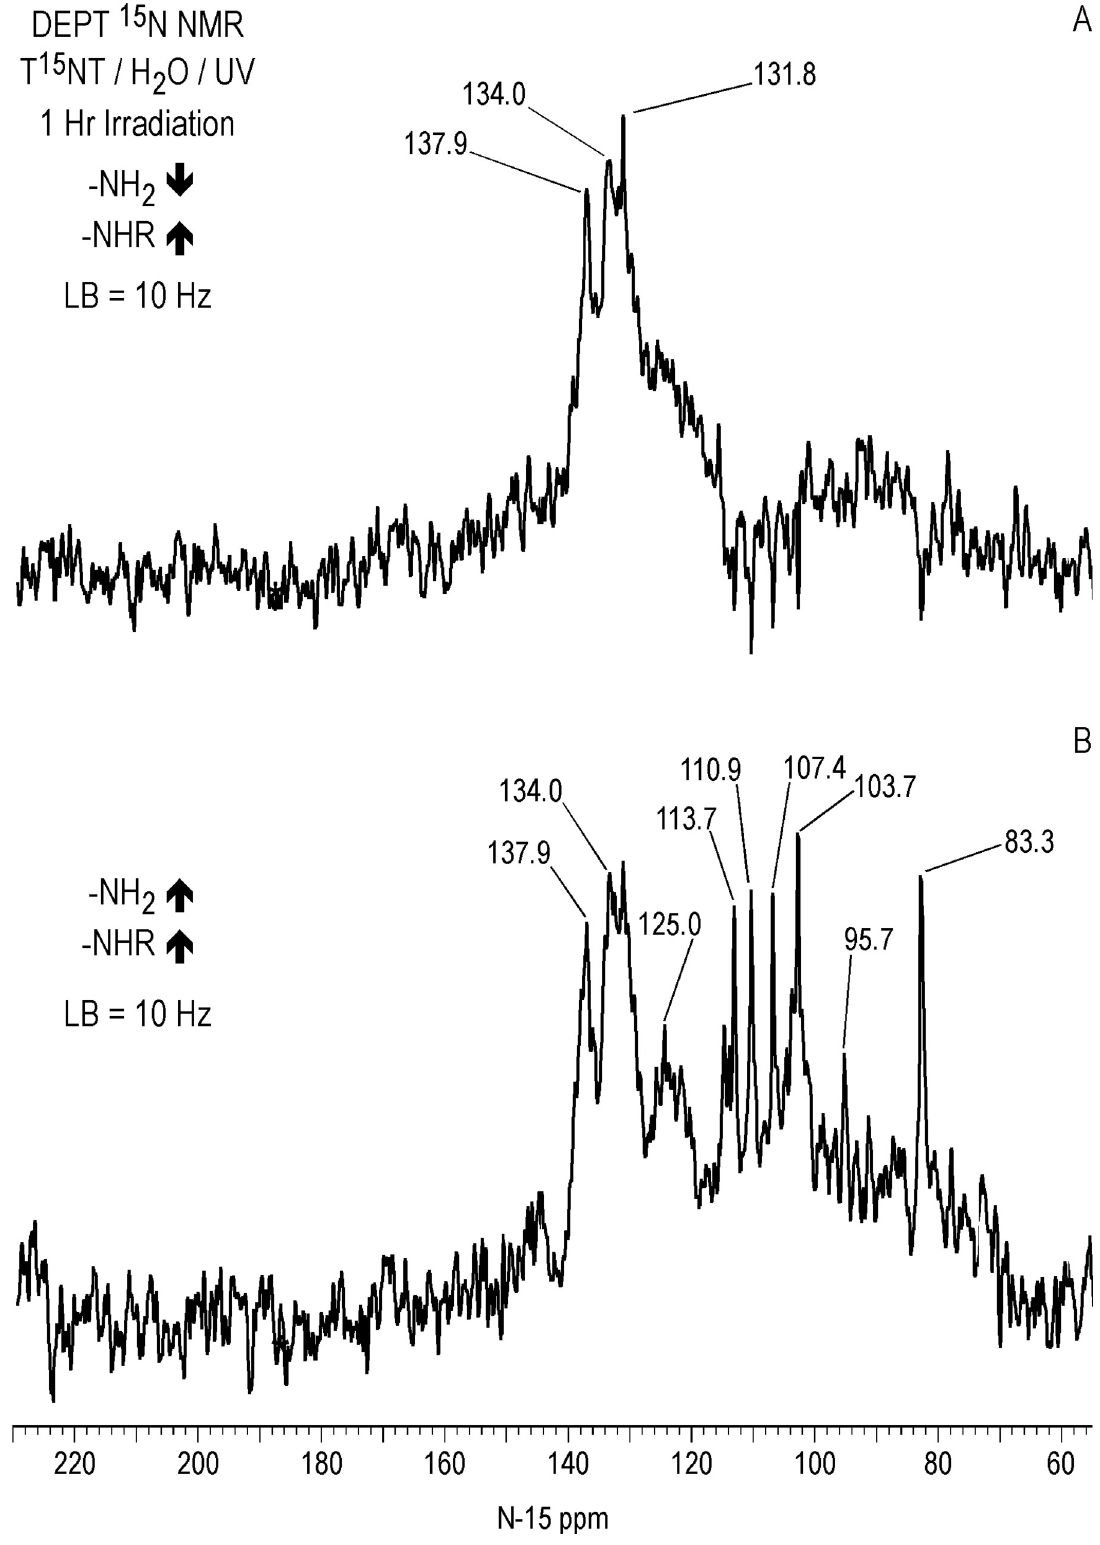
Fig 13. Liquid state N-15 NMR DEPT spectra of T 15 NT subjected to lamp irradiation in deionized water. A. Nitrogens bonded to two protons in negative phase and nitrogens bonded to one nitrogen in positive phase. B. All nitrogens bonded to protons in positive phase. LB = line